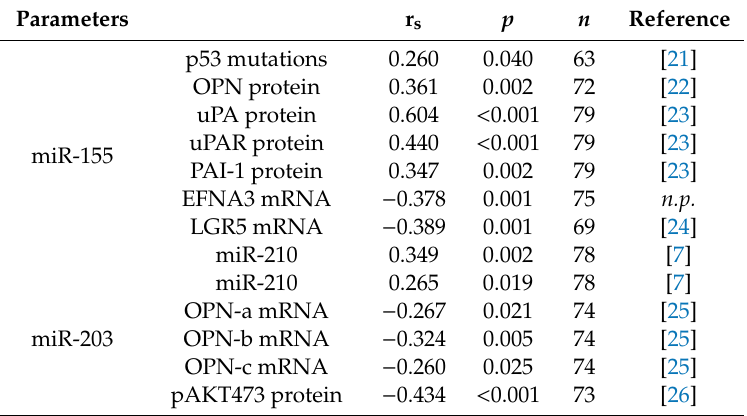
Table 1. Bivariate correlation analyses (Spearman-Rho) with miR-155 or miR-203 and different molecular-pathological factors in soft tissue sarcoma.